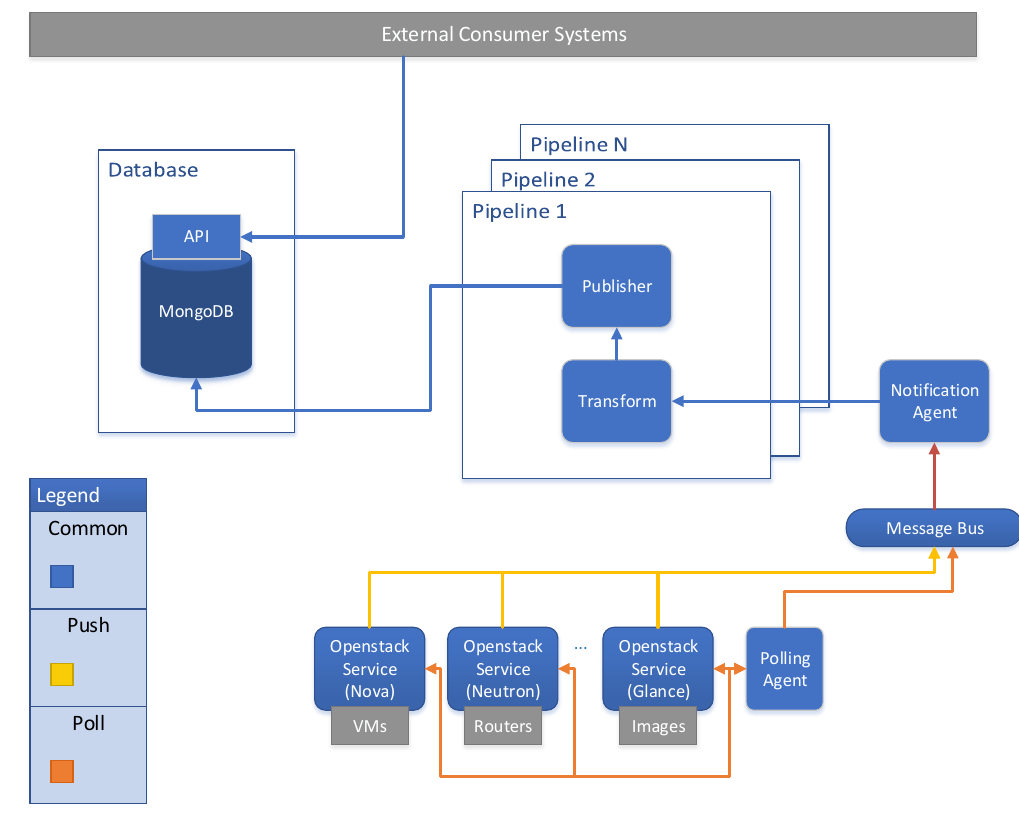
Figure 13. Ceilometer Architecture.